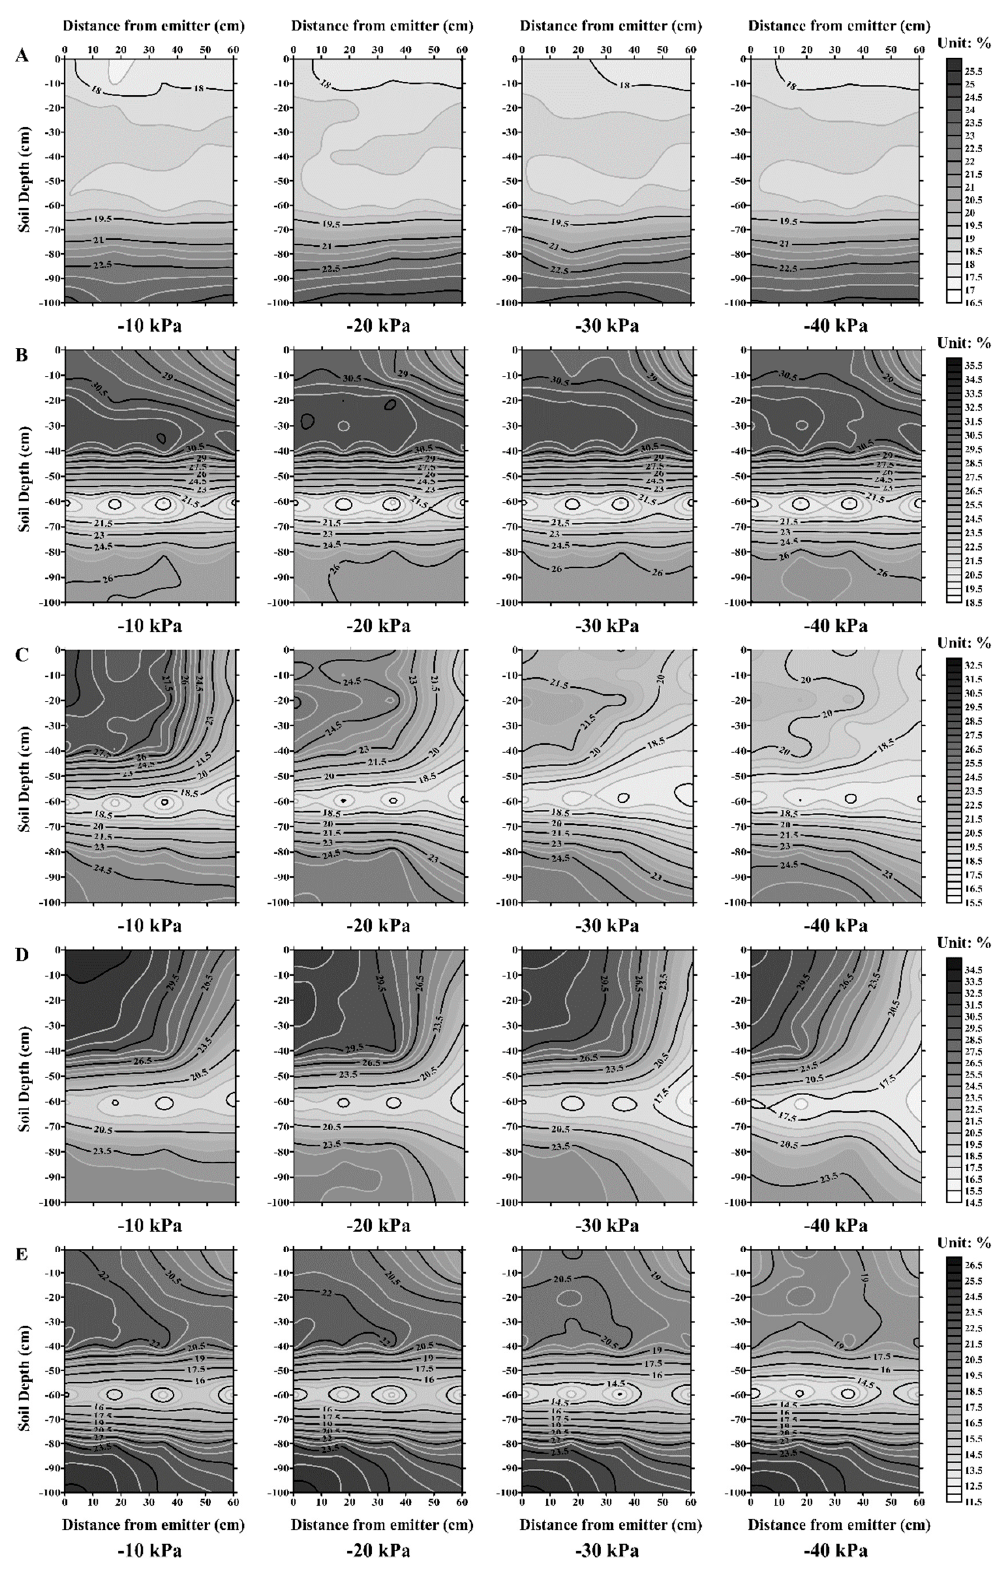
Figure 6. Spatial distribution of soil moisture along the vertical transect that is perpendicular to the drip line ( A ) before spring irrigation, ( B ) before sowing, ( C ) before the irrigation at the jointing stage, ( D ) after the irrigation at the jointing stage, and ( E ) after harvest, for all treatments in 2015.